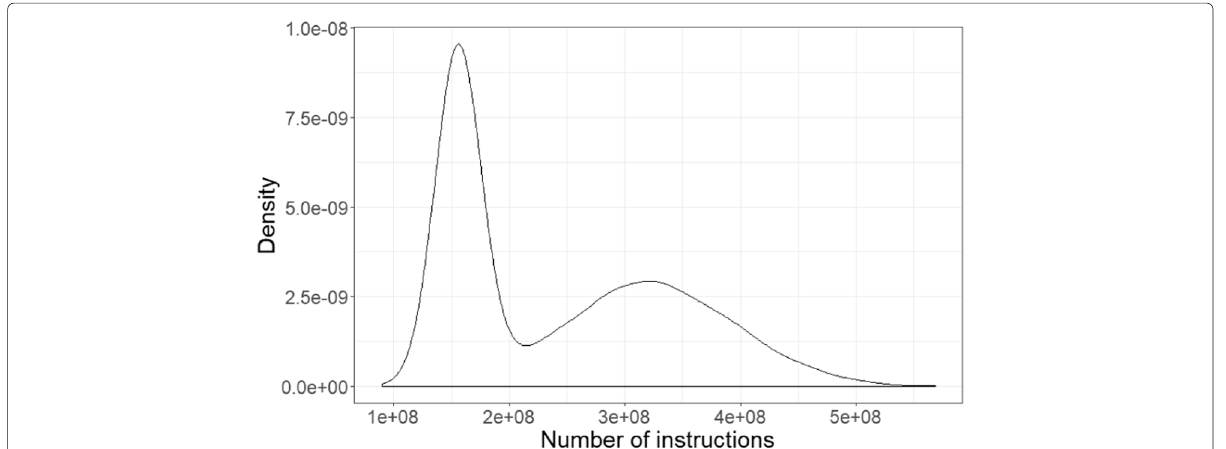
Fig. 13 Density function of the fitted